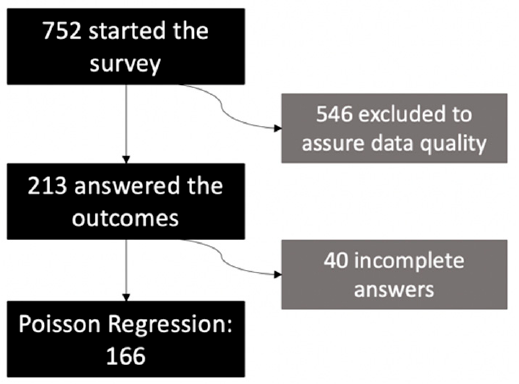
Figure 1. Participants sampling flowchart.